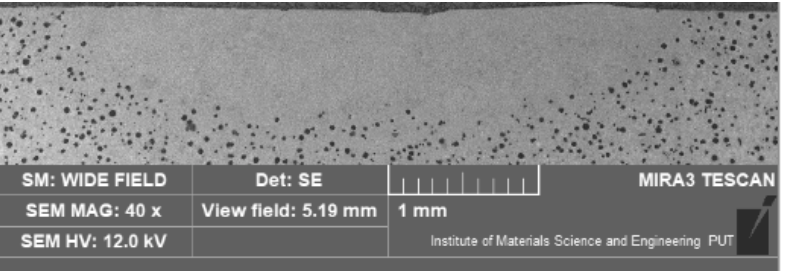
Figure 8. The cross-section of the surface layer of nodular iron after laser alloying with silicon nitride (electron scanning microscope, etched with nital 3%).